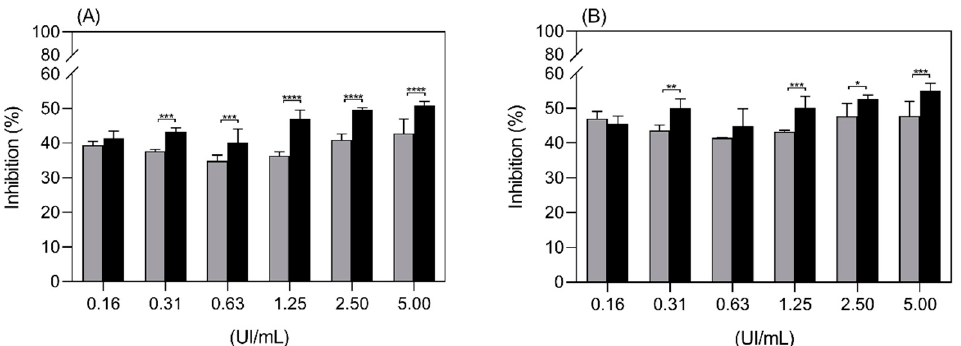
Figure 8. Inhibition of proliferation of the K562 cell line by ASP-enzymosomes (black bars) and ASP (grey bars) at 48 h ( A ) and 72 h ( B ). Each point is the mean of six replicates, ±SD, from one representative experiment. * p -value < 0.5 and **** p - value < 0.0001. Results from Figure 9, which compare the inhibition of proliferation of the Jurkat cell line by ASP and ASP-enzymosomes, demonstrate an equivalent antiproliferative effect for both preparations. Thus, the soluble substrate reacted equally with the naked or the stealth enzyme attached to the PEG distal end point. Accordingly, the delivery system was not detrimental to the asparaginase in vitro activity, which is an important feature of the ASP-enzymosome formulation.